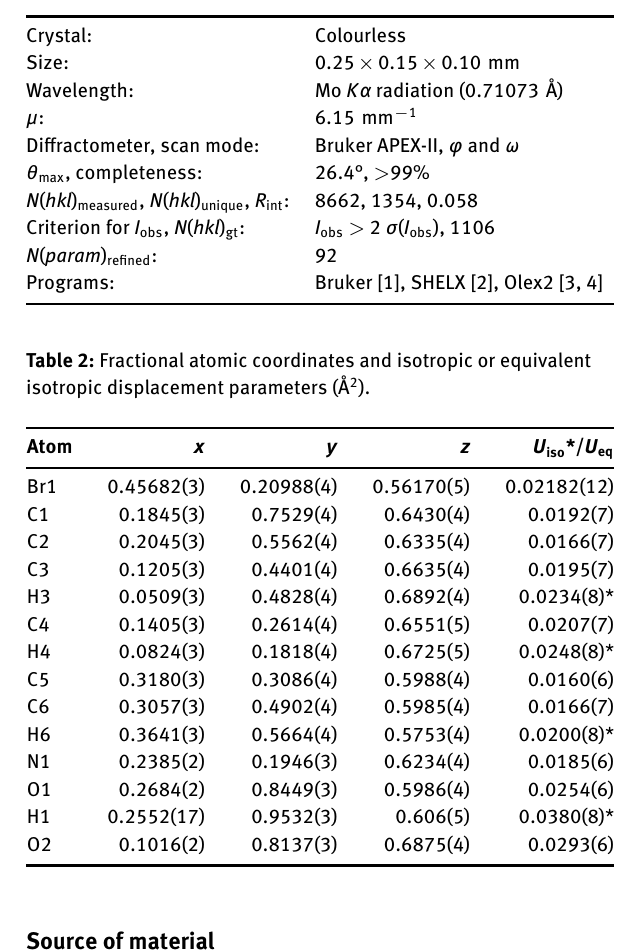
Table 1: Data collection and handling.